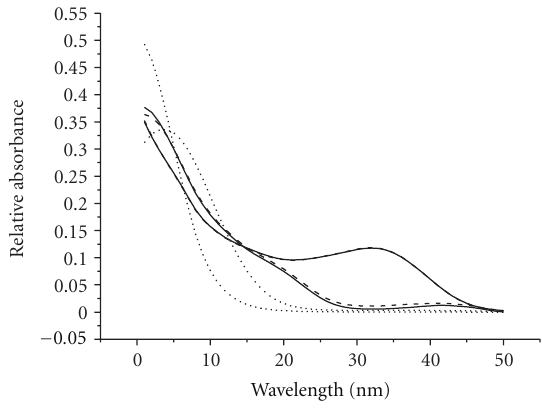
Figure 4: Normalized UV-Vis spectral profiles were resolved by the SWATLD in human plasma. Solid and dotted lines represent the UV-vis spectral profiles of vancomycin, cephalexin, and interfer- ence. The medium dash denotes the actual vancomycin and cepha-